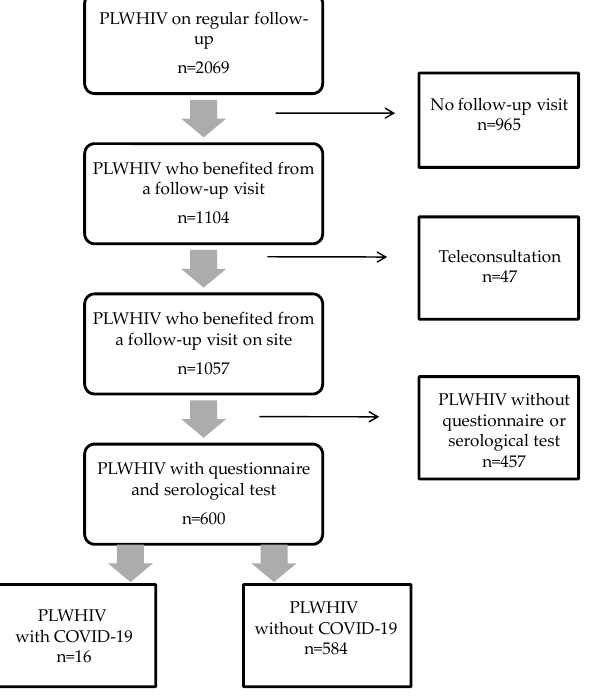
Figure 1. Patient Figure 1. Patient flowchart.